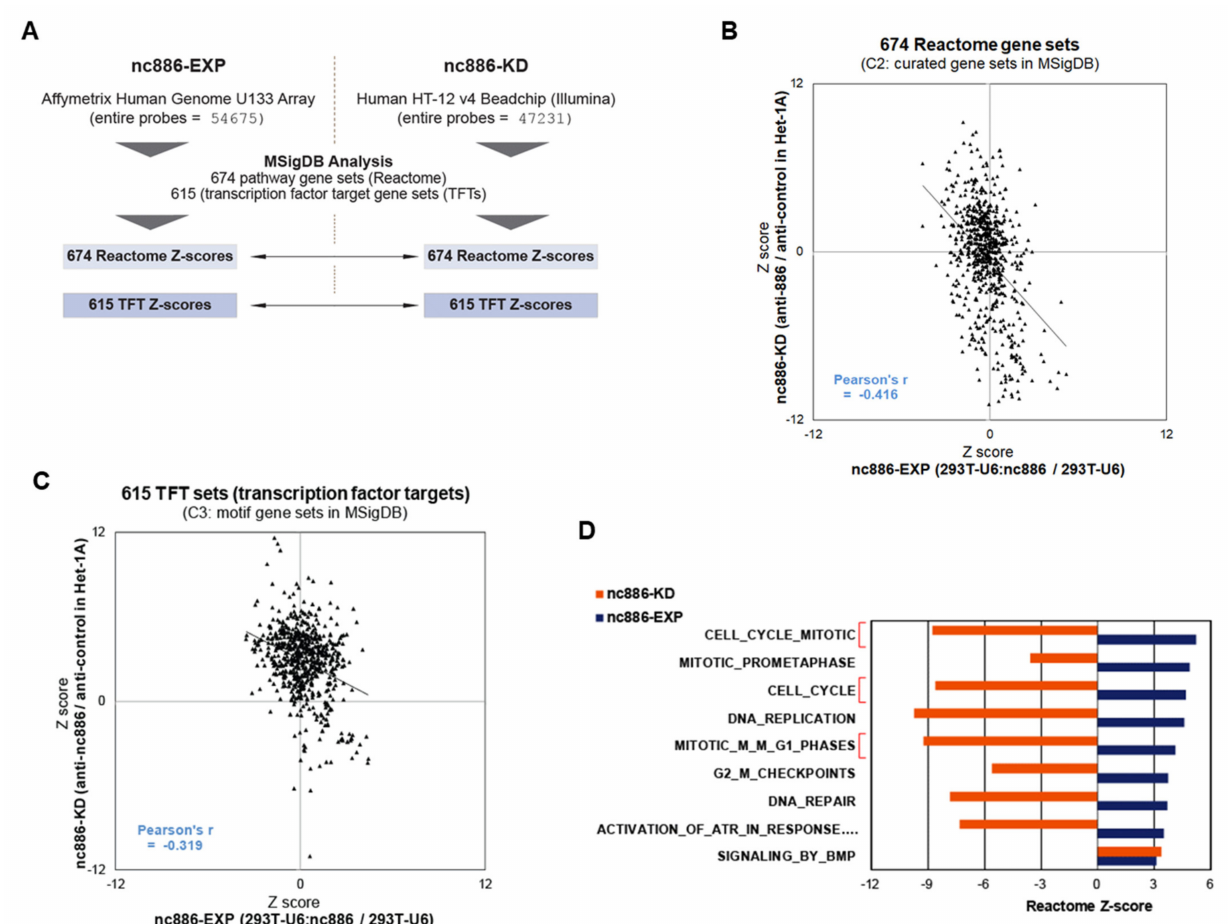
Figure 3. Pathway analyses from the array data of nc886-EXP and nc886-KD. ( A ) Summary of array platforms and analysis workflow. ( B ) A scatter plot of Z-scores for 674 Reactome gene sets that shows the correlation between nc886-EXP (x-axis) and -KD (y-axis). ( C ) A scatter plot of Z-scores for 615 transcription factors (TFs) target gene sets (TFTs), as described in panel B. ( D ) A bar graph showing Z-scores for Reactome gene sets. Nine pathways with a significantly enriched Z-score ( > 3) were selected from nc886-EXP and were plotted together with Z-scores of